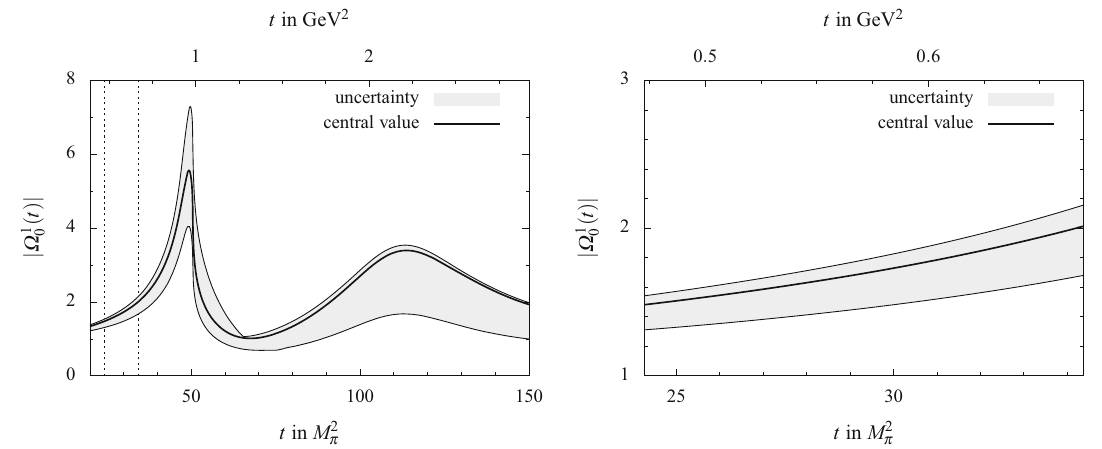
( t ) | , calculated from the πη S -wave effective phase shift δ 1 0